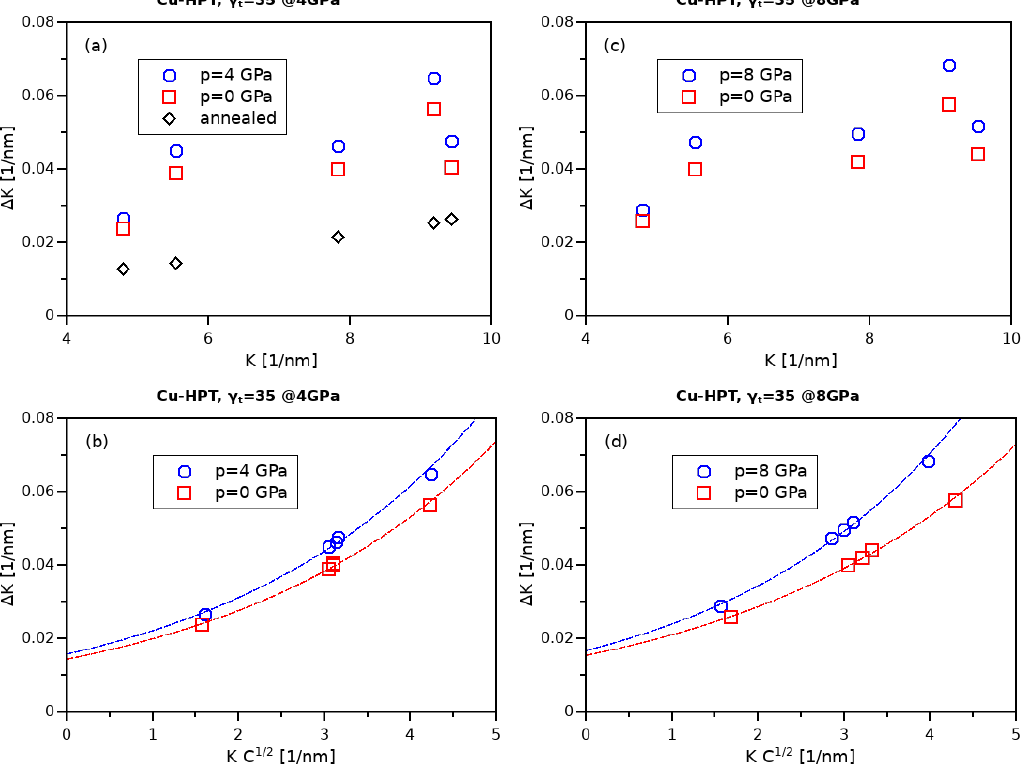
Figure 2. Williamson–Hall plot and modified Williamson–Hall plot for copper after high-pressure torsion (HPT) deformation at 4 ( a and b ) and 8 GPa ( c and d ), respectively. “ p = 0 GPa” denotes the sample state after the pressure release